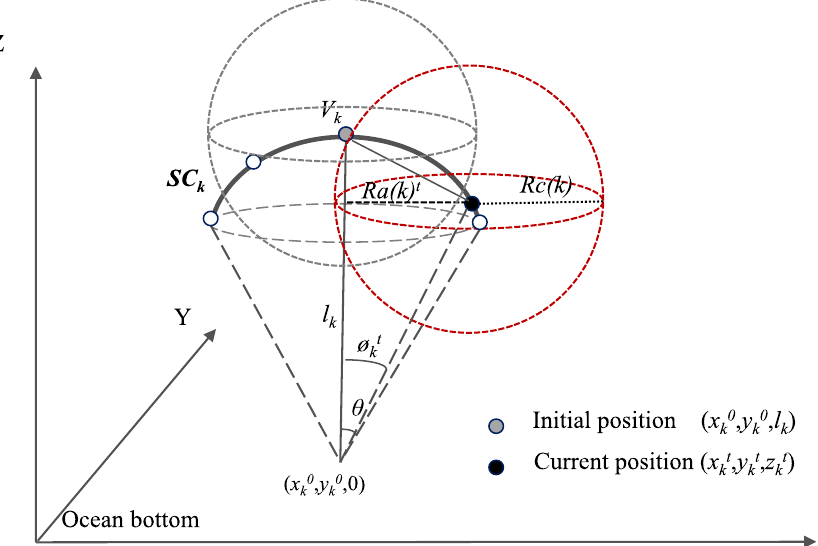
Fig. 2 Model of node